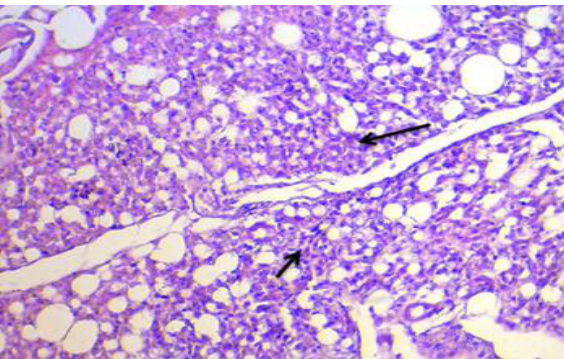
Figure,6: Section of chicken lung tissue showed degeneration of alveolar sac and alveoli and infiltration of lymphocytes (black arrows). There is interstitial infiltration of mononuclear cell in the lung observed around the bronchioles and bronchi. (H&E stain).